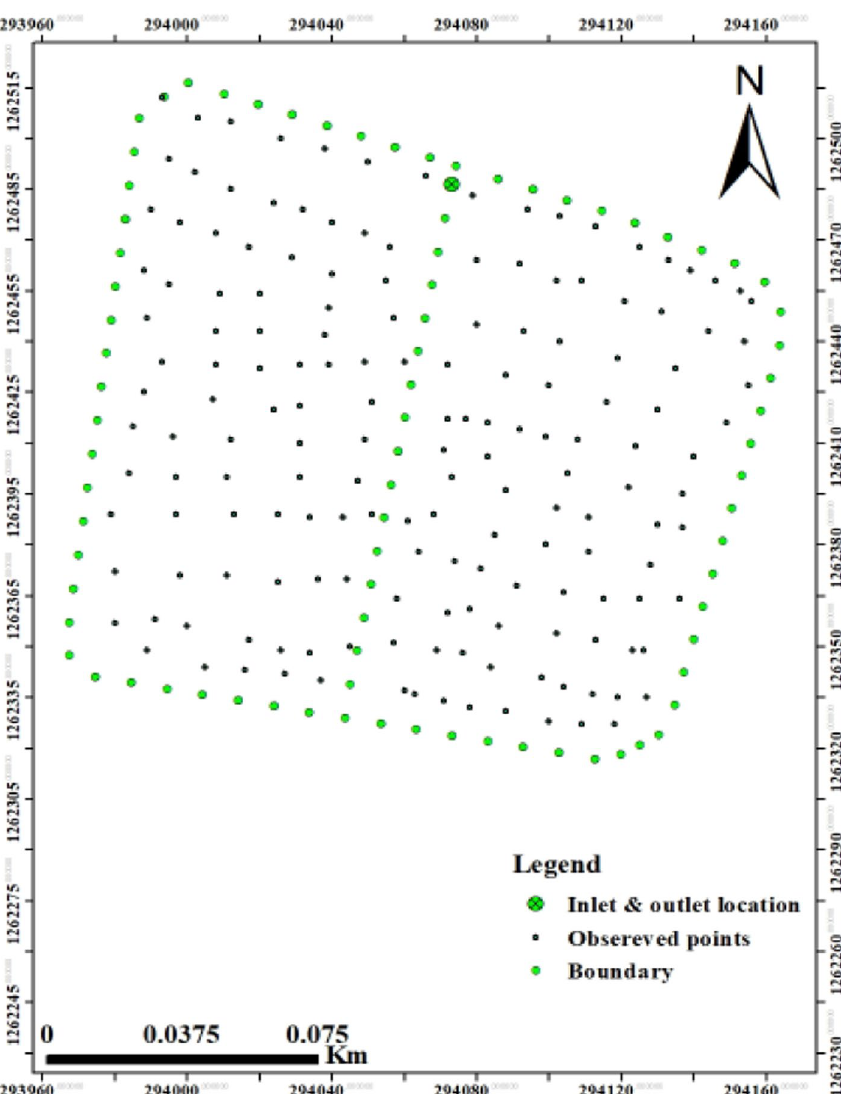
Fig. 6 Adebra NSR bathymetric